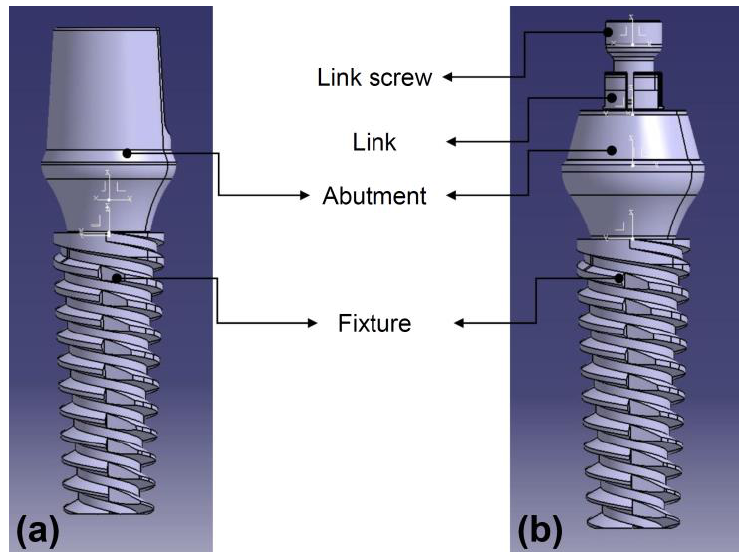
Figure 1. Schematic illustration of the prosthetic components used in this study. ( a ) Cement-retained and ( b ) cementless, screw-retained zirconia crown models.